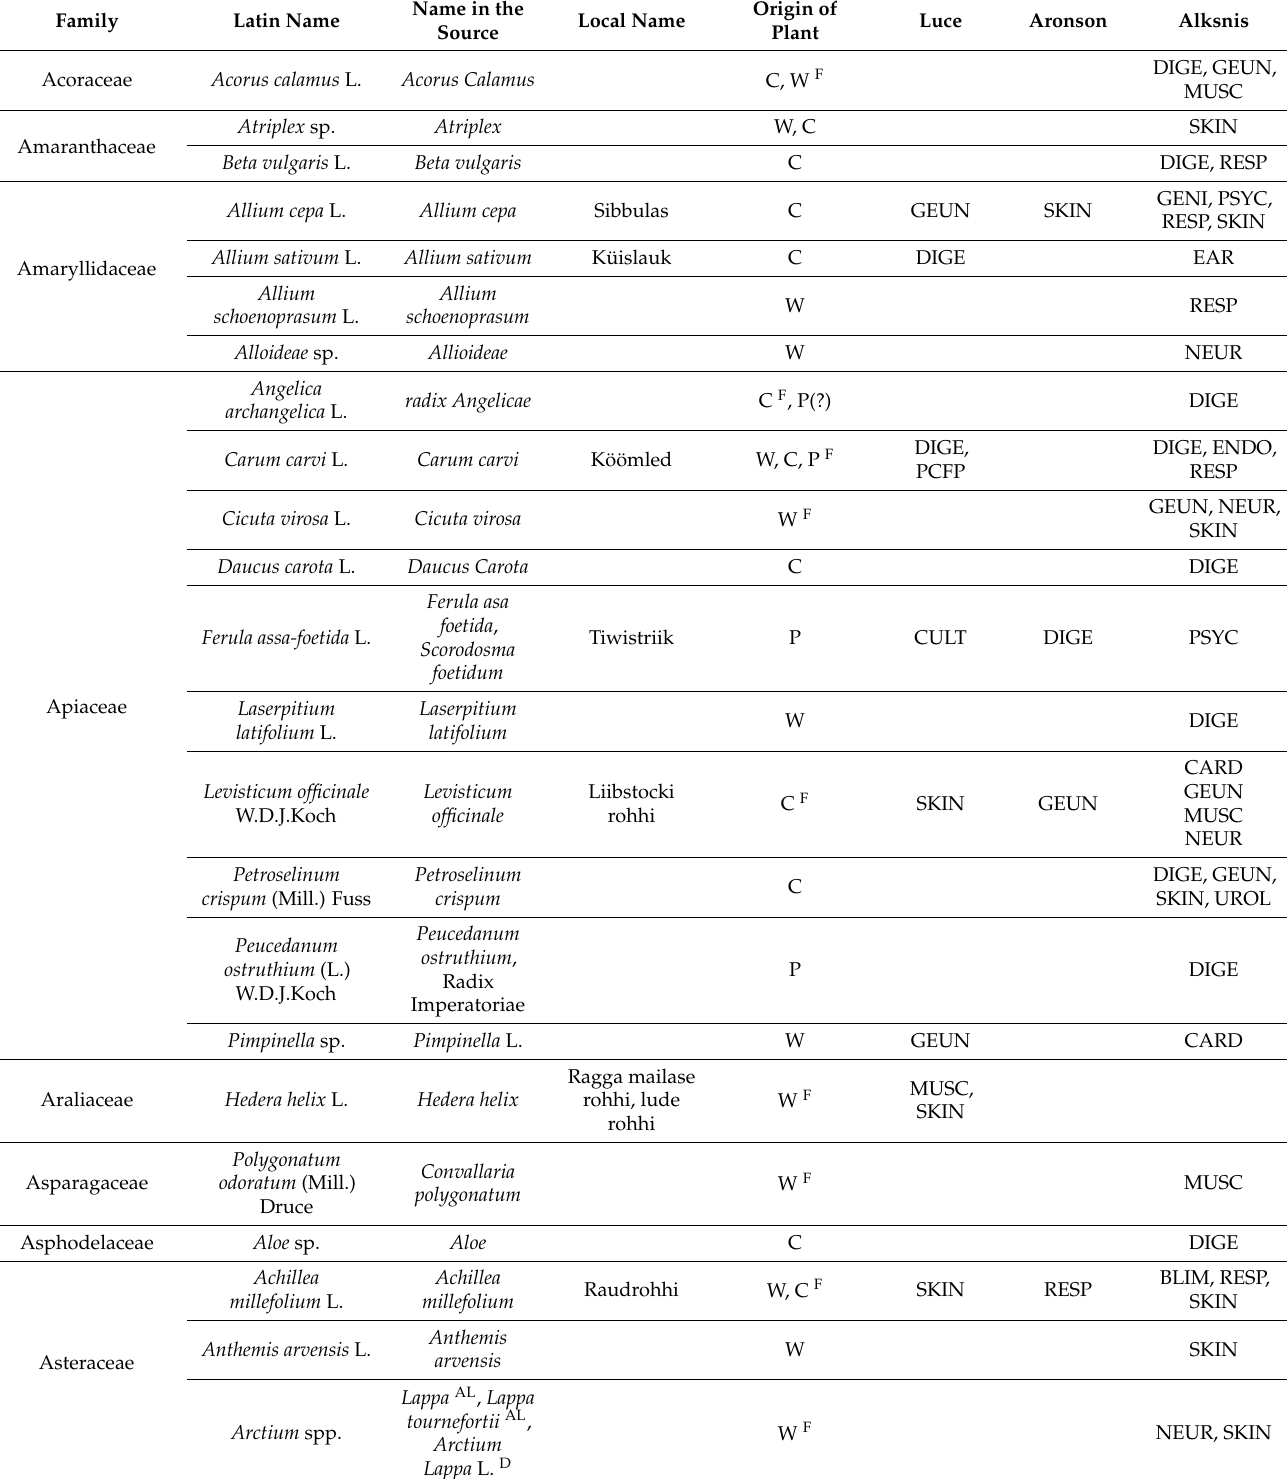
Table 1. Plants named by all three authors and general disease